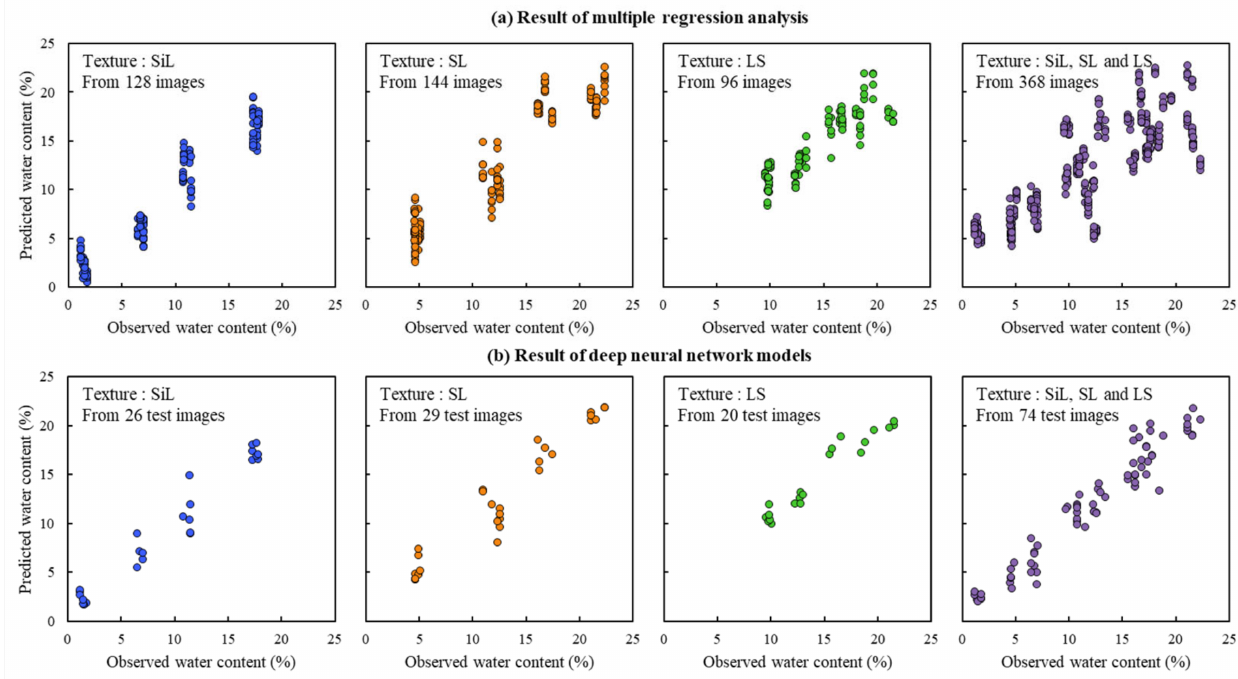
Figure 6. Prediction result of water content using features from soil surface images produced by multiple regression analysis and the deep neural network regression